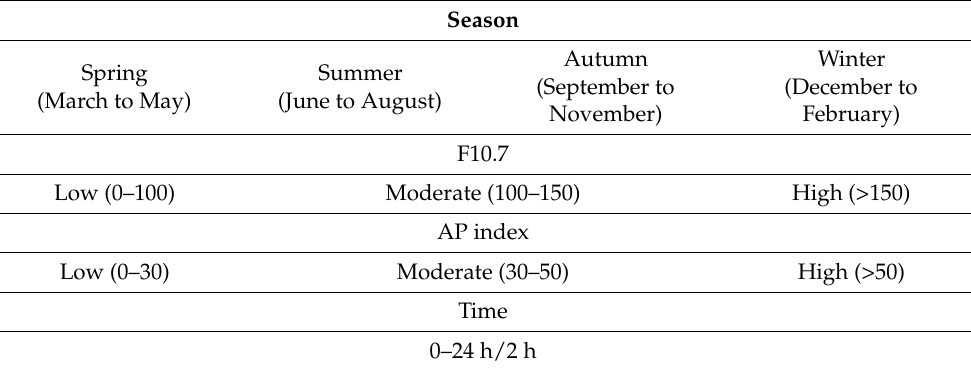
Table 1. Data division